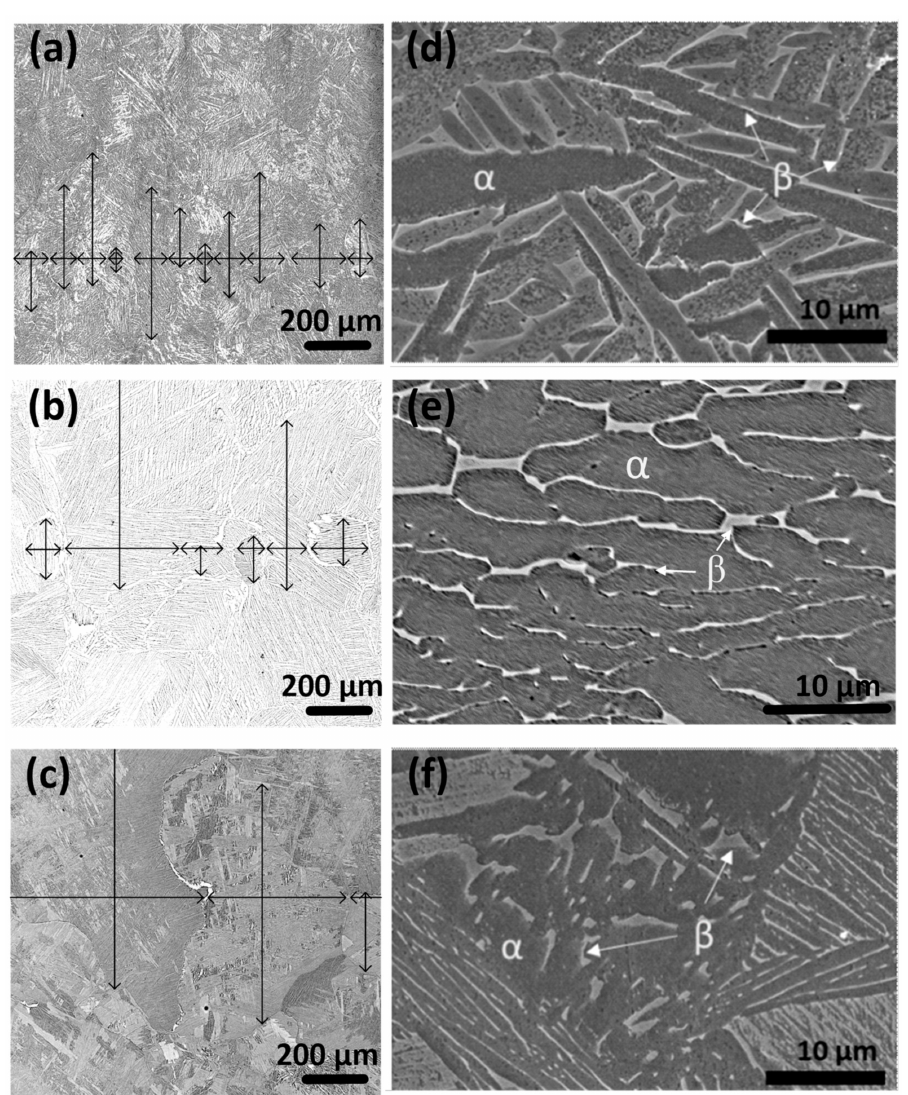
Figure 8. ( a – c ) Optical microscopy and ( d – f ) SEM images after ( a , d ) PT1, ( b , e ) PT2, and ( c , f ) PT3. Arrows indicate the width and length of prior β